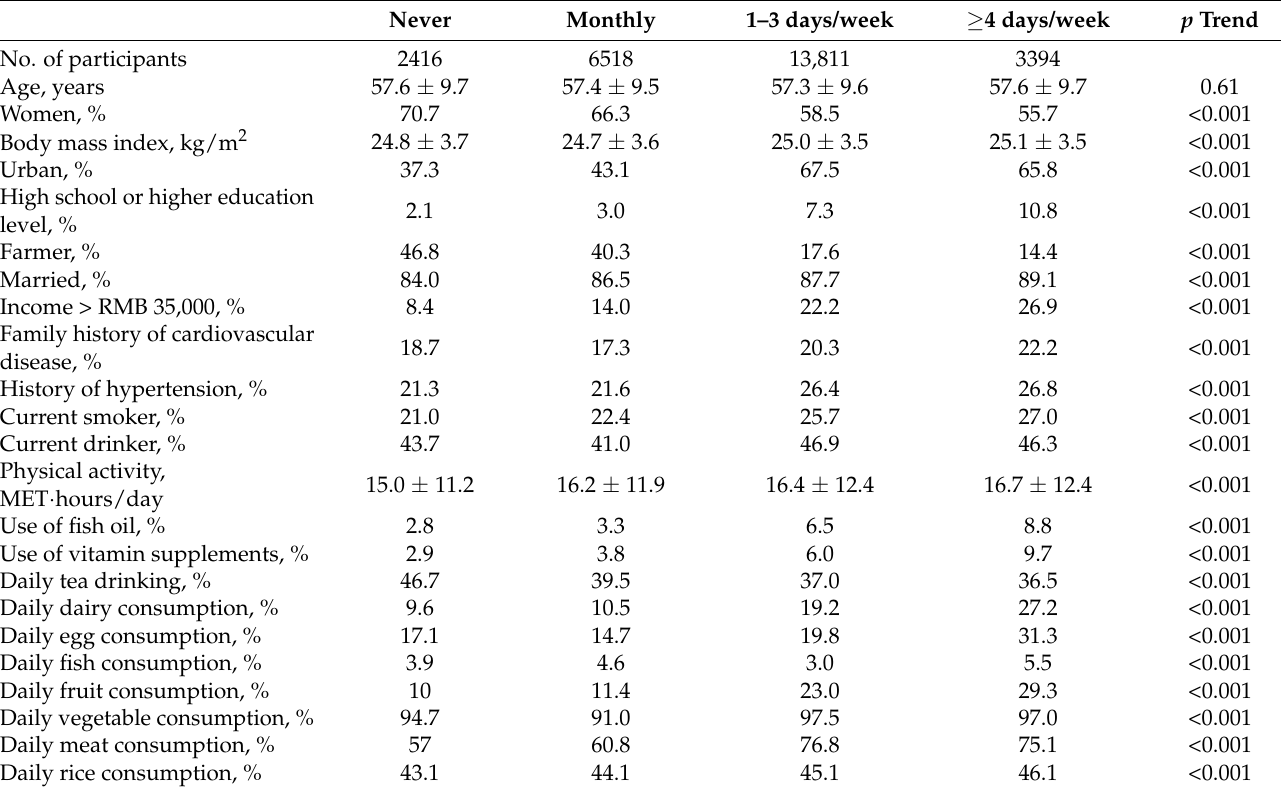
Table 1. Baseline characteristics of individuals with a history of type 2 diabetes according to soy consumption